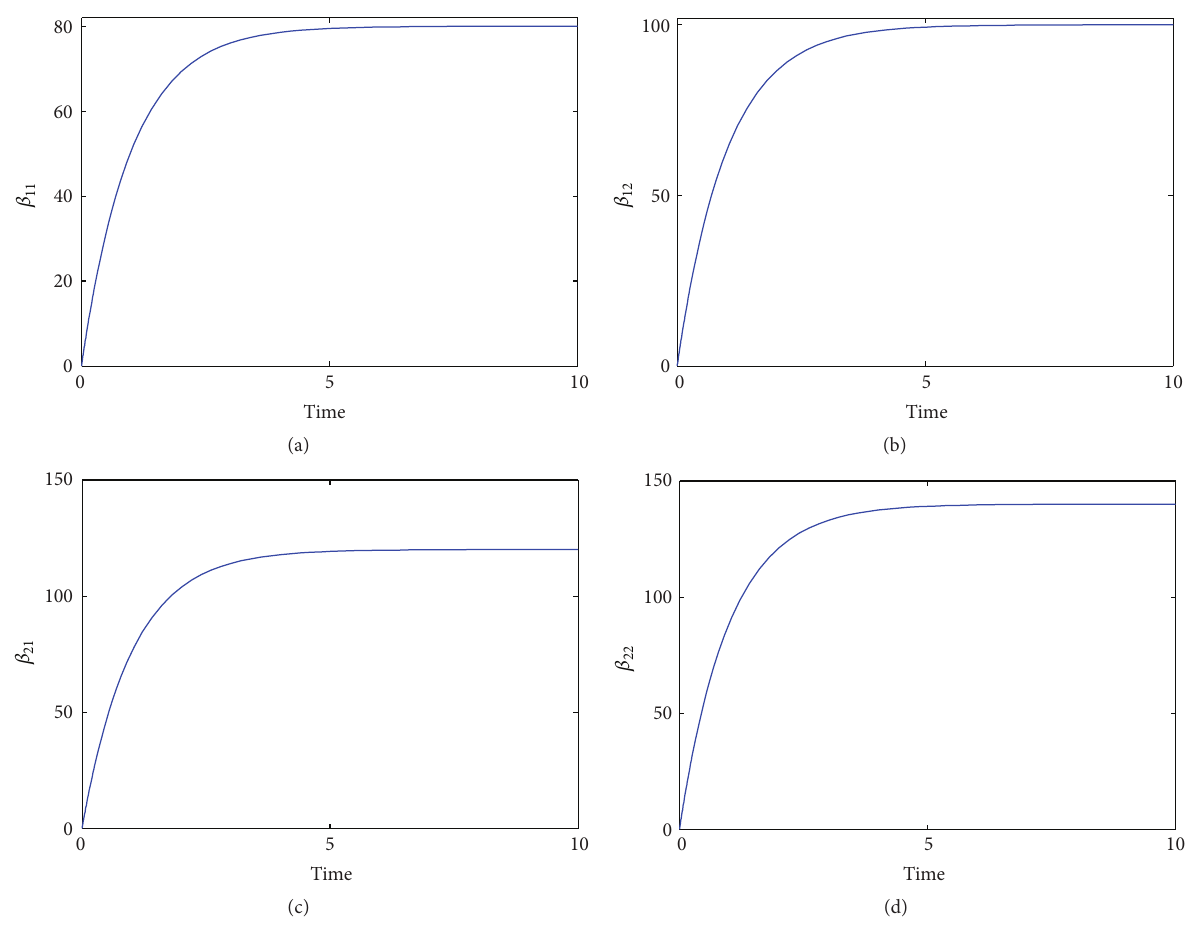
Figure 6: Simulation results of the adaptive parameters with 𝛽 ∗ 11 = 80 , 𝛽 ∗ 12 = 100 , 𝛽 ∗ 21 = 120 , and 𝛽 ∗ 22 = 140 .